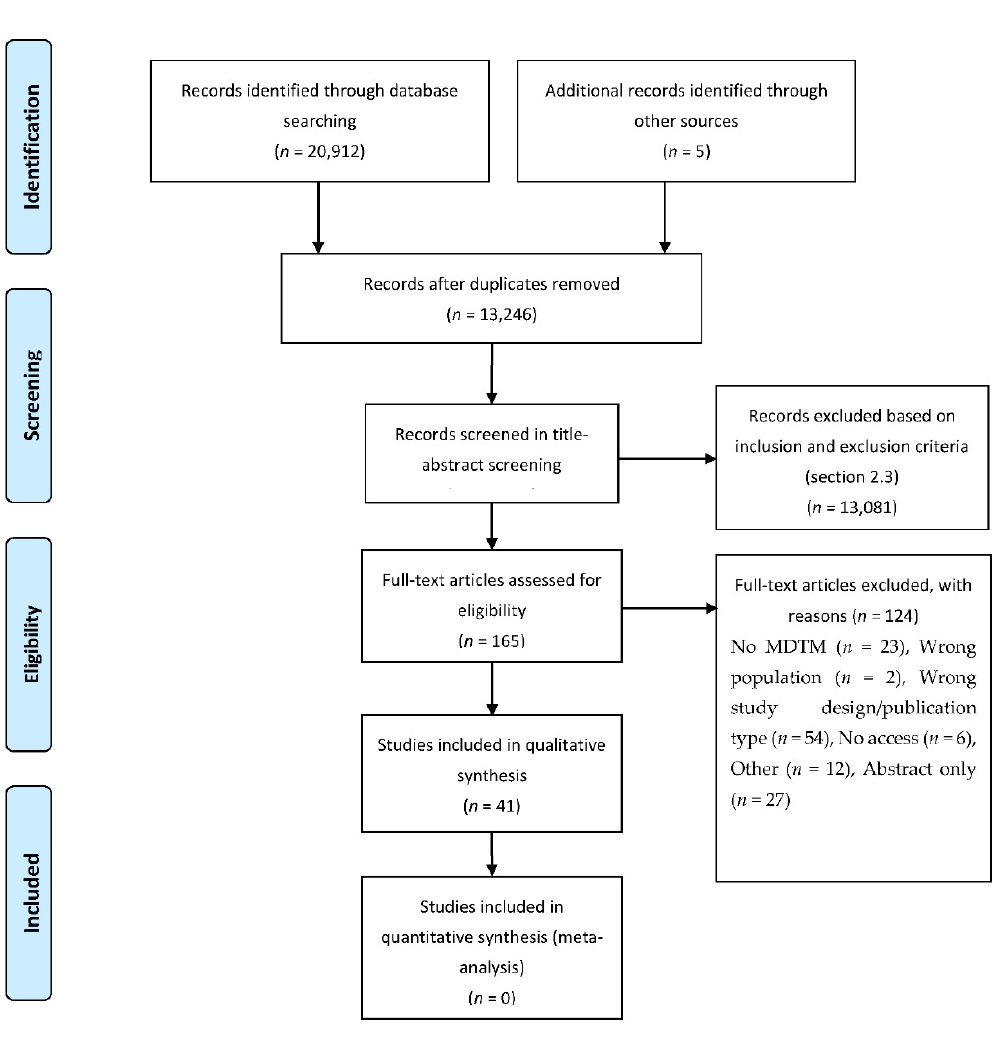
Figure 1. PRISMA-P 2015 flowchart.